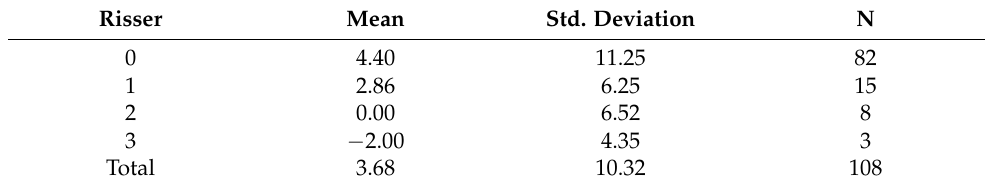
Table 3. Ancova test, differential score between the post-test and the pre-test (2-1), Lenke clasification. LENKE Type Mean